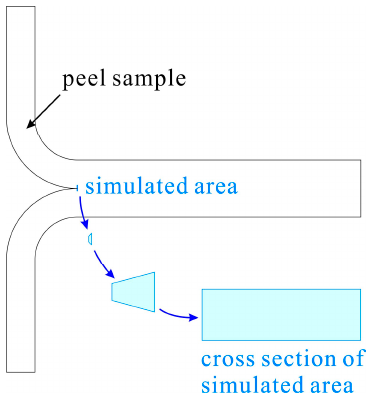
Figure 10. Peel sample and simulated area.